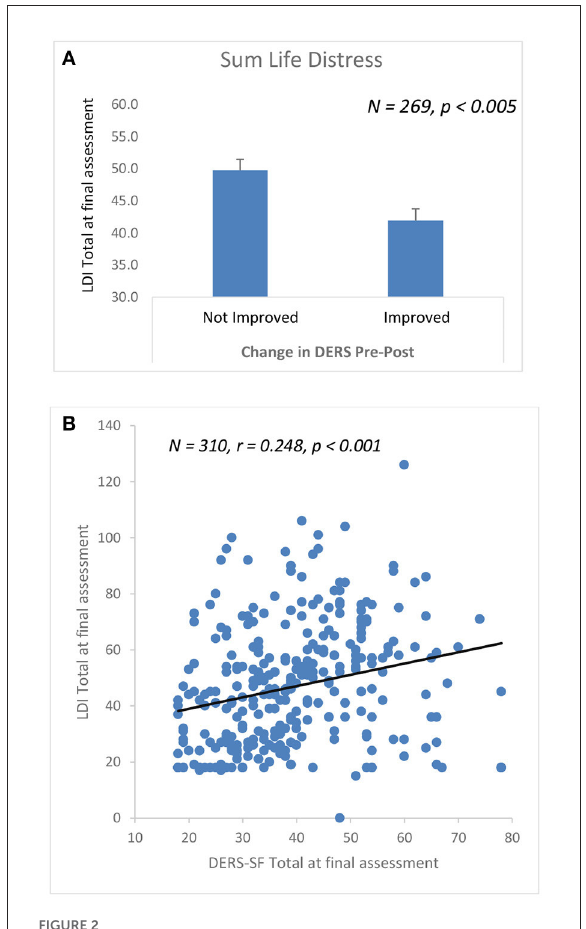
FIGURE2 Improvement in emotion regulation associates with overall decreased life distress across Roca intervention. (A) Clients with greater improvement in emotion regulation over the course of ROCA CBT (higher levels of pre-post DERS-SF difference scores), also have significantly less Life Distress at last visit ( p < 0.005). (B) Positive correlation between overall DERS-SFand sum LDI (e.g., better emotion regulation (lower DERS-SF), less life distress (lower LDI), ( r = 0.248, p < 0.001, N =